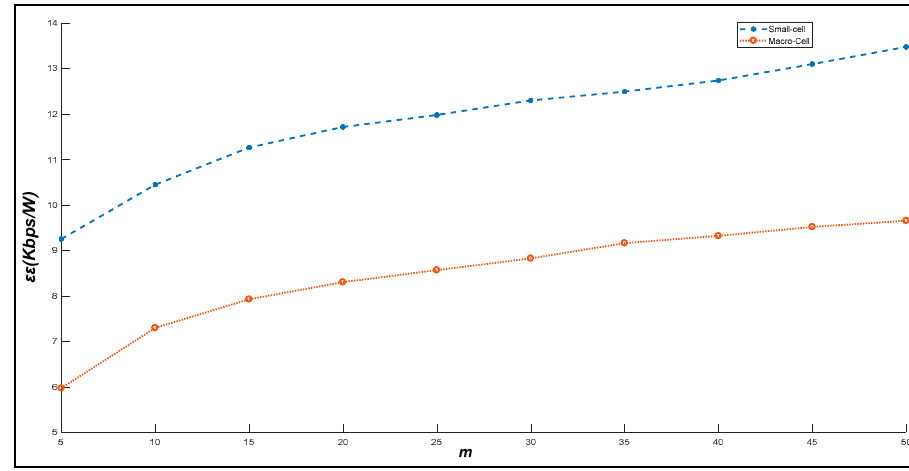
Figure 10. D2D energy efficiency of small-cell and macro-cell scenarios vs. m.